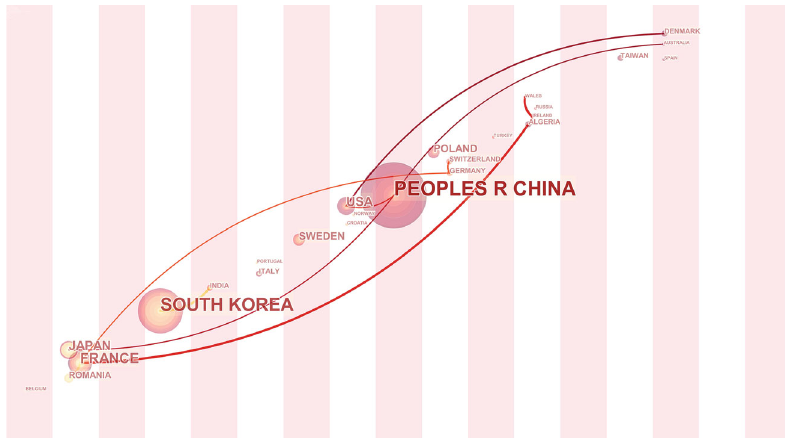
Figure 3: Time-zone diagrams of di ff erent countries participating in the PET-based material for separator application. Table 1: The number and centrality of published papers in di ff erent countries. Country Centrality Paper no. Country Centrality Paper